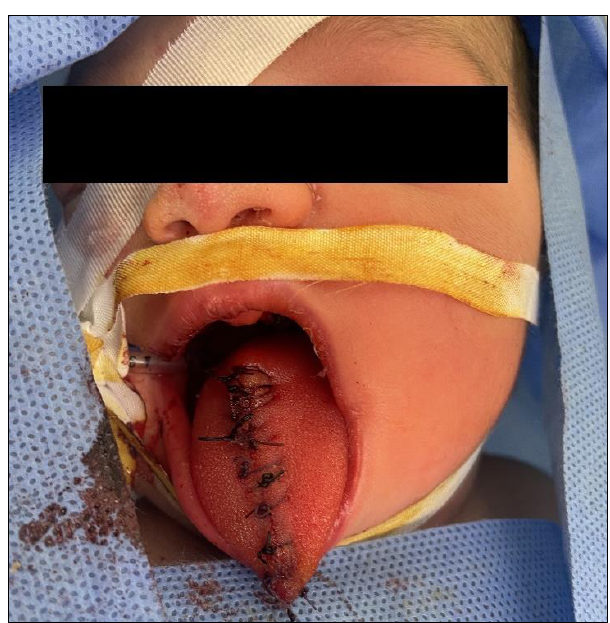
Figure 3: Excision of both masses with the repair of the bifid tongue The palatine mass (4×3×2.5 cm) was pedunculated and its excision was straightforward. The